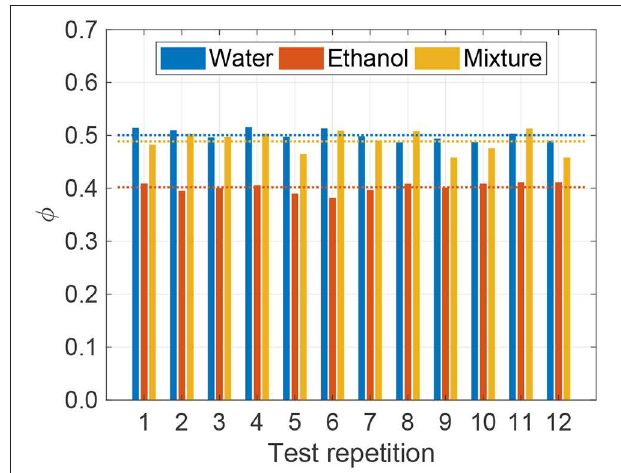
FIGURE 2 | Loaded liquid fraction ( φ in Equation 1) obtained for twelve repetitions of the experimental characterization test at ambient pressure ( p = 1 bar) and temperature ( T = 20 ◦ C) on pristine zeolite samples for the different tested fluids (water, ethanol and 30:70%wt. ethanol-water mixture). The dotted lines show the mean value over the repetitions for the three different